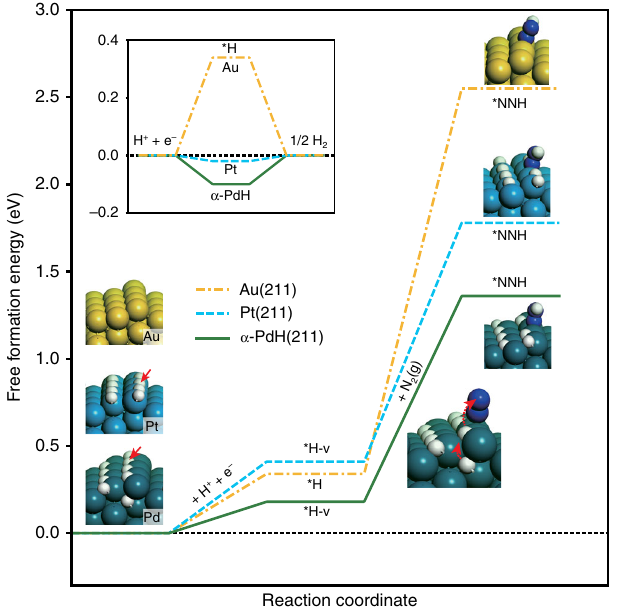
Fig. 4 Computational studies. DFT-calculated free energy pathways of HER (inset) and the relevant steps of N 2 RR on the (211) surfaces of Au, Pt, and α -PdH at surface potential of 0 V vs. RHE under 298.15 K (atomic structures shown in the insets). The fi rst step denotes the formation of *H on the Au surface and *H vacancy (*H-v) on Pt and α -PdH step sites. The second step is the direct surface hydrogenation of N 2 (g) forming *N 2 H on Au and Pt, and the Grotthuss-like hydride transfer pathway on α